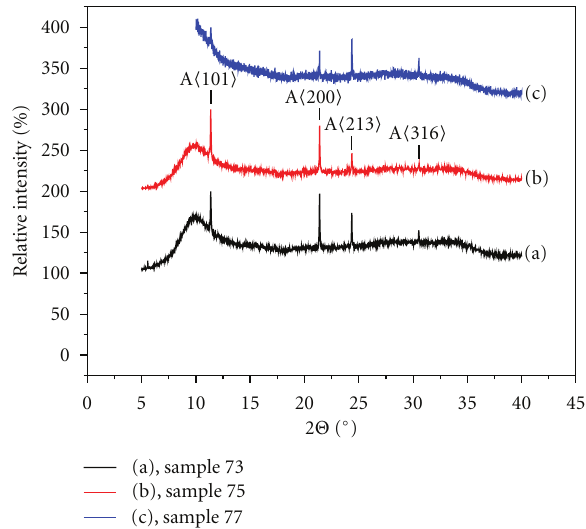
Figure 1: X-ray di ff raction patterns for anatase TiO 2 :(Fe, S) thin films obtained from the internal evaporator in a controlled Ar/O 2